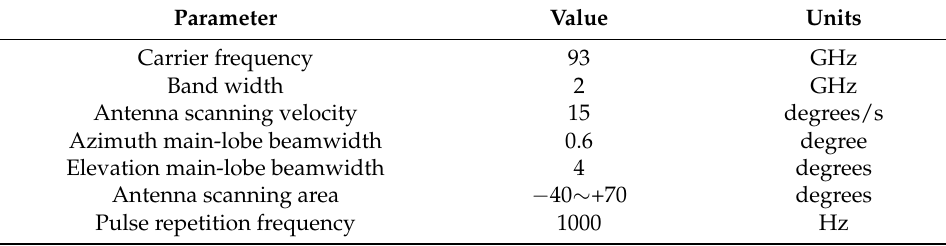
Table 1. Parameters of the FOD millimeter-wave radar system.